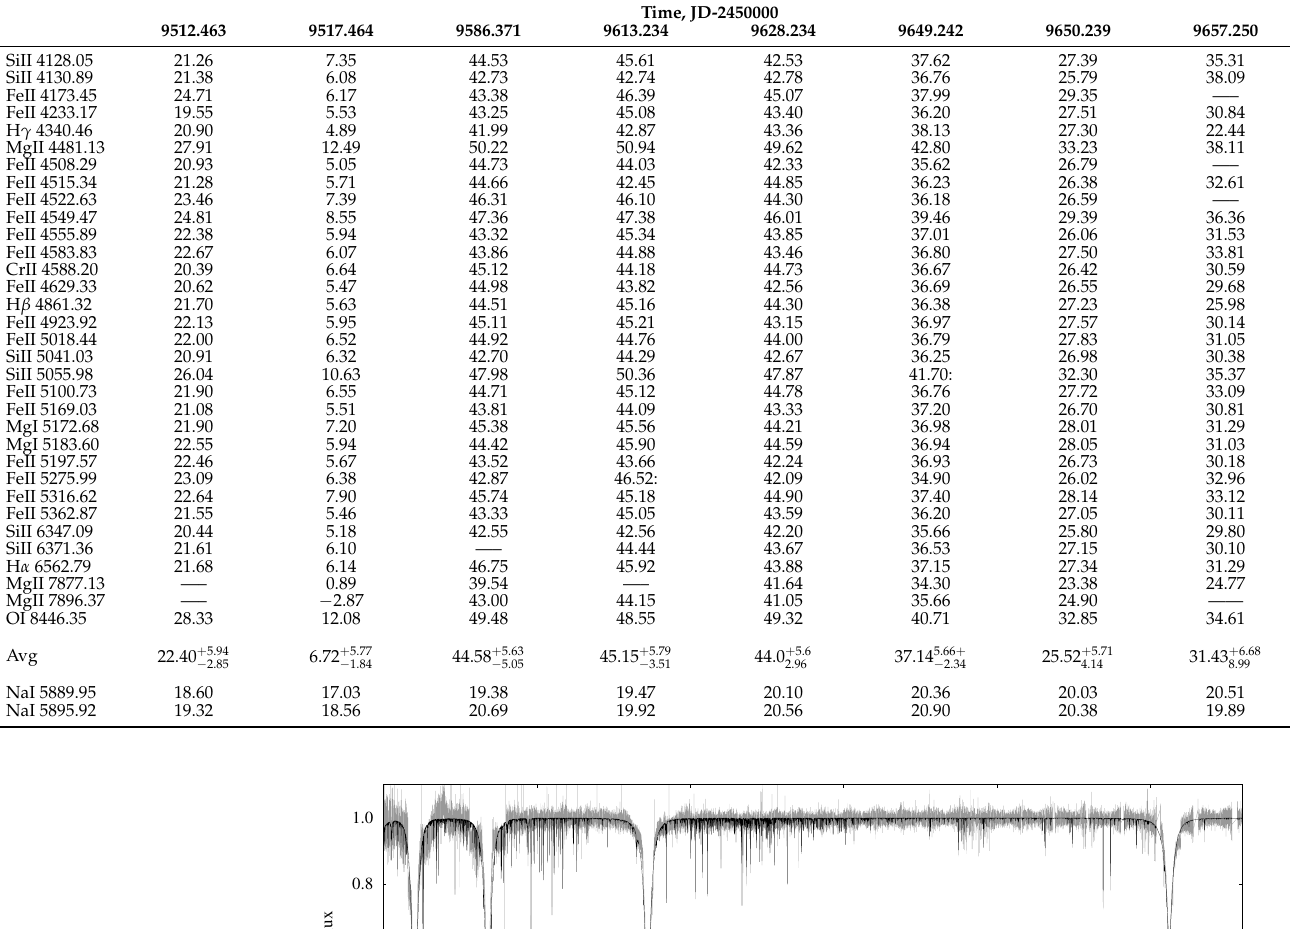
Table 2. Radial velocity measurements for different lines on different nights; Avg is average values for radial velocity. The colons after values mark the data with lower accuracy of position determination.